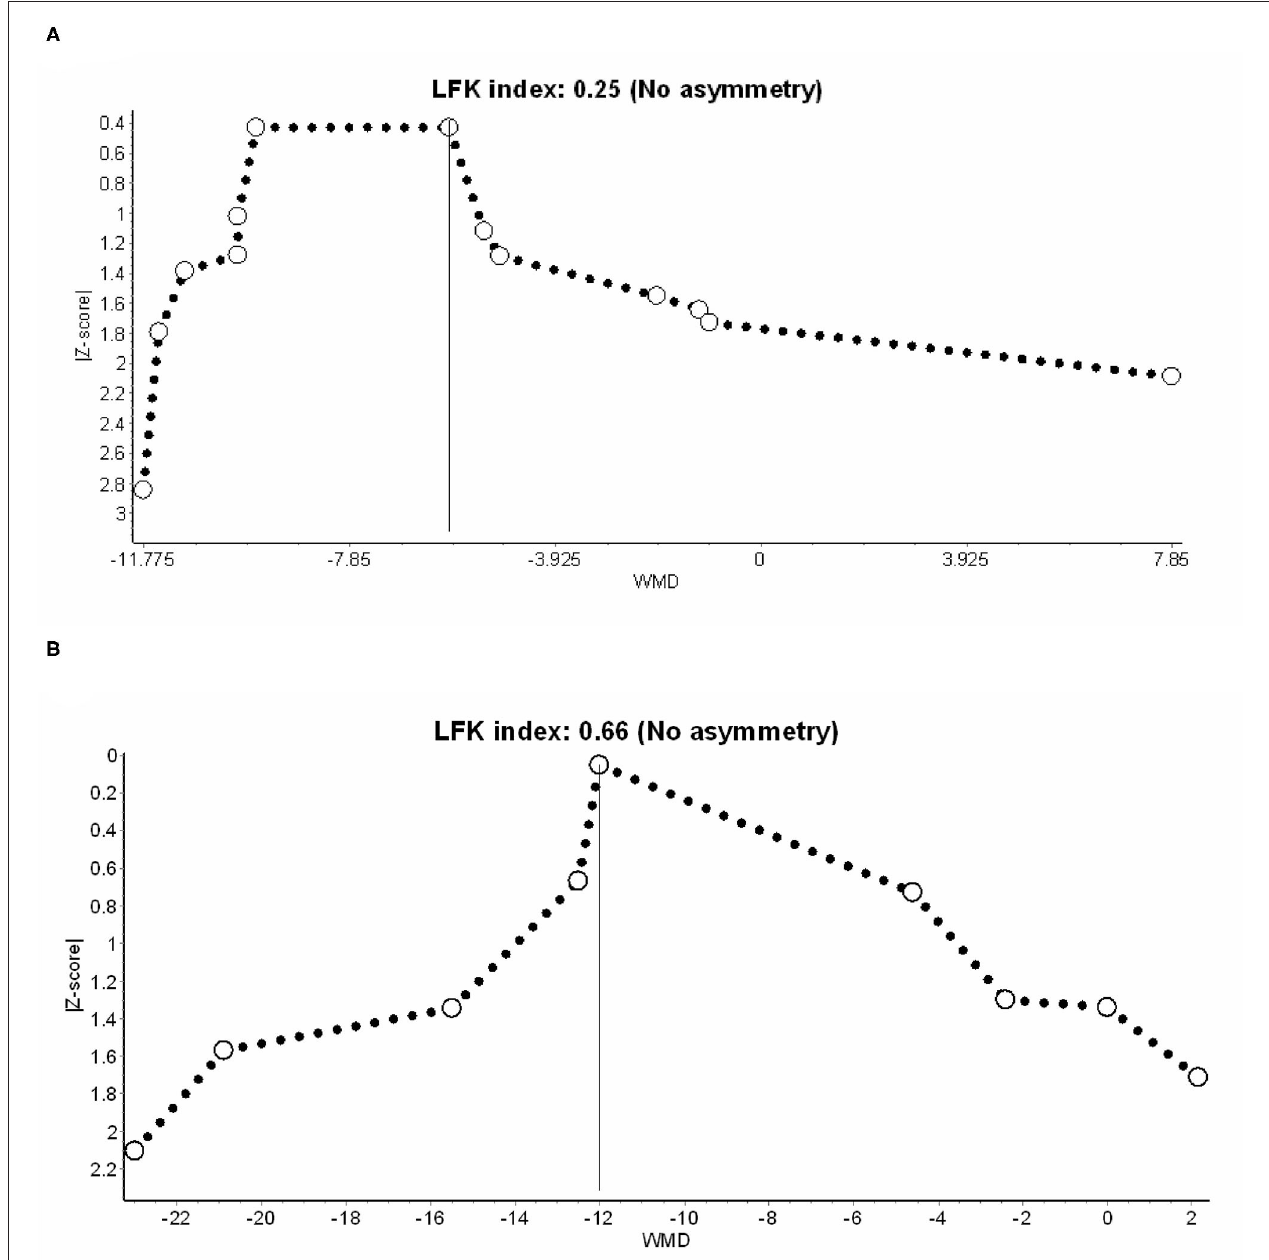
FIGURE 5 | Publication bias in (A) time to first flatus and (B) defecation, presented with the Doi plot. LFK index, Luis Furuya–Kanamori index.